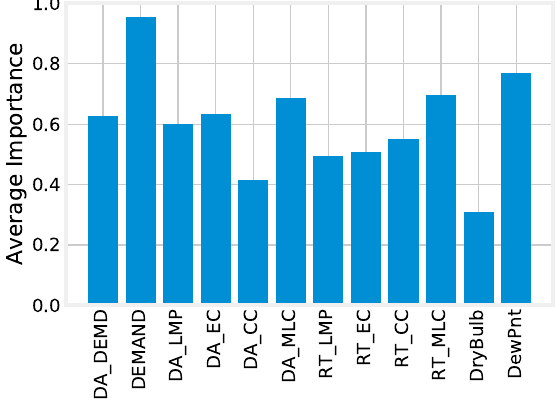
Figure 10. Average feature